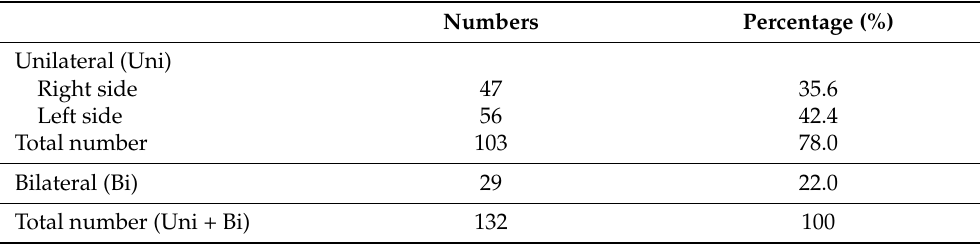
Table 2. Site distribution of cleft lip and palate. Patients with unilateral cleft lip and palate is subdivided into right and left side.